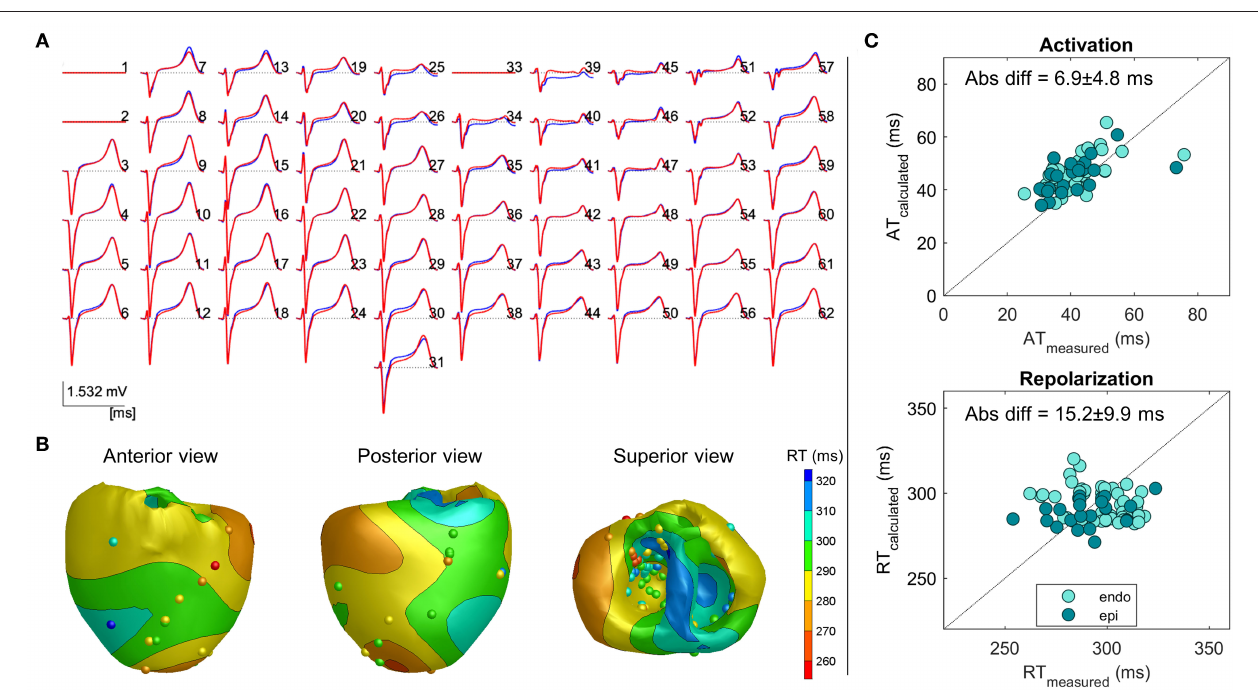
FIGURE 2 | Example 1: Inverse reconstruction of heart 4, atrially paced beat. (A) Superimposed measured (blue) and reconstructed (red) body surface ECGs. Isoelectric lines represent bad recording electrodes (channels 1, 2, and 33). (B) Three views of the heart, with surface color indicating the inverse calculated repolarization pattern, spheres indicating electrode measurement sites, and color indicating the corresponding measured repolarization time (RT). (C) Measured vs. calculated activation time (AT; upper panel) and RT (lower panel) on electrode sites, with a distinction between the endocardial and epicardial